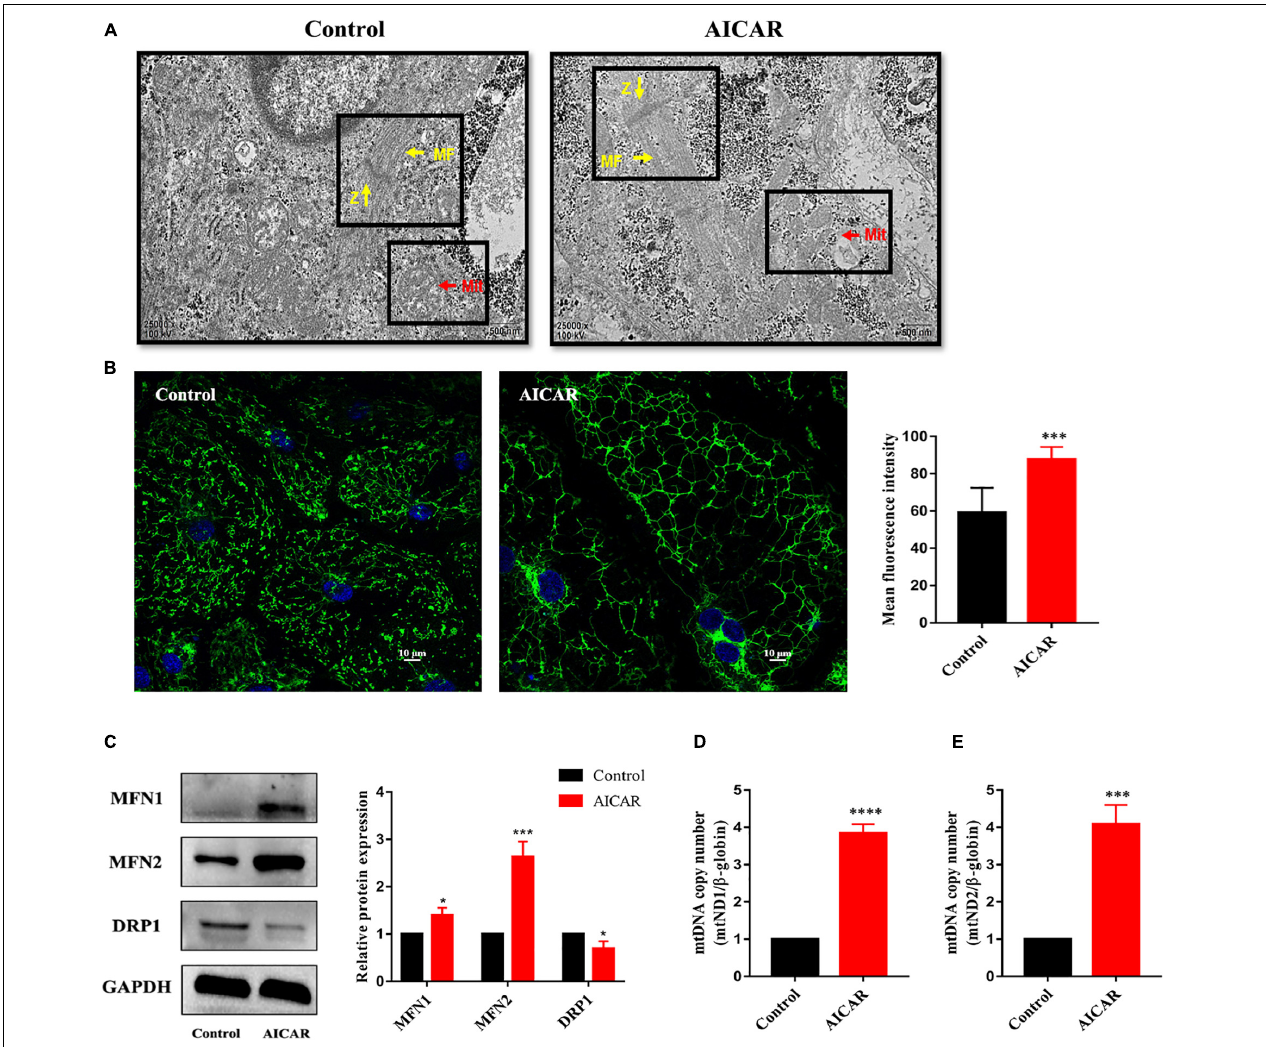
FIGURE 7 | Activation of AMPK improves mitochondrial maturation of hiPSC-CMs. (A) Transmission electron microscopy images of hiPSCs treated with AICAR or control showing the differences in mitochondrial morphology. Scale bar, 500 nm. The number of mitochondria in AICAR-treated hiPSC-CMs was increased, and AICAR-treated hiPSC-CMs contained more mitochondrial crista than those in the control. Z, Z-bands, yellow arrows; MF, myofibrils, yellow arrows; Mit, mitochondria, red arrows. (B) MitoTracker green was used to investigate the changes in mitochondrial morphology in hiPSC-CMs treated with AICAR or control. The mean fluorescence intensity of MitoTracker green in hiPSC-CMs treated with AICAR vs. control ( n = 80–100 cells/group). Scale bar, 10 µ m. (C) Western blot analysis of MFN1, MFN2, and DRP1 protein expression in hiPSC-CMs treated with AICAR (vs. control) ( n = 3). Mitochondrial DNA content determined by RT-qPCR using primers for mt-ND1 (D) and mt-ND2 (E) normalized to the housekeeping gene β -globin ( n = 3). * P < 0.05, *** P < 0.001, **** P < 0.0001compared with the control group, unpaired t